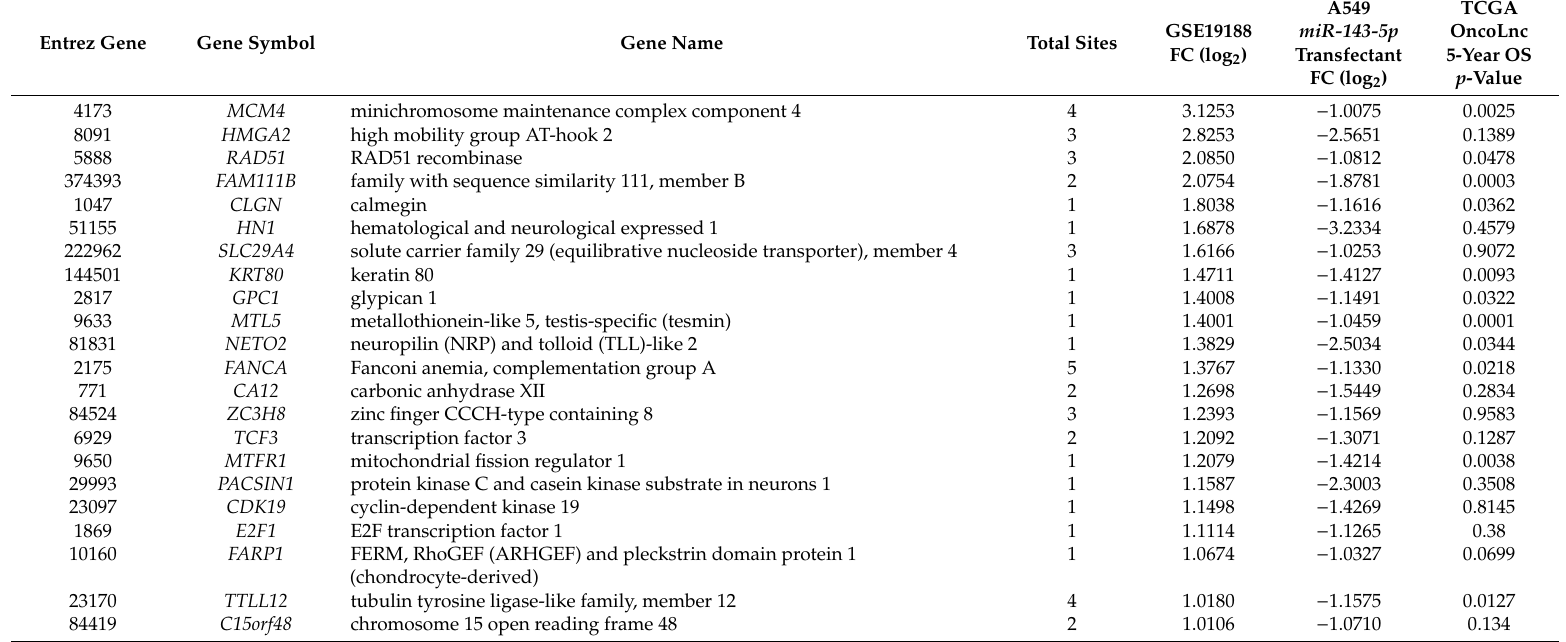
Table 2. Candidate target genes regulated by